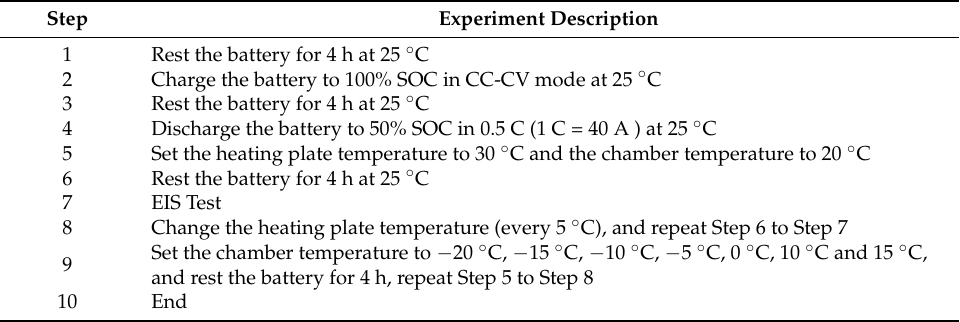
Table 2. EIS experiment with the temperature